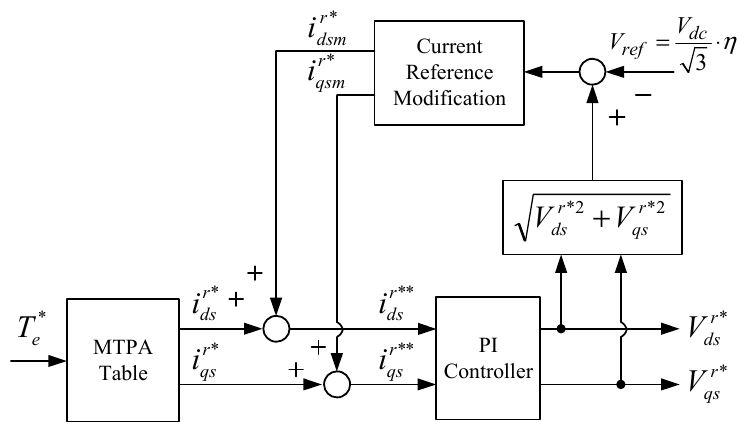
Figure 5. Block diagram of the proposed algorithm.